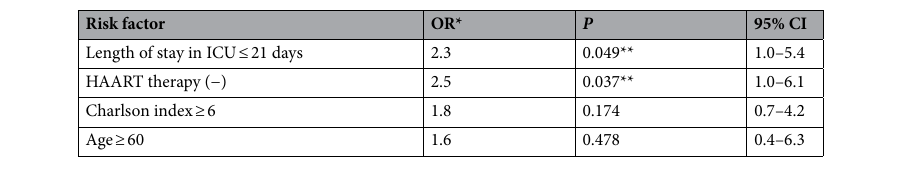
Table 2. Logistic regression analysis of risk factors for mortality in HIV patients in the ICU. *OR adjusted with length of stay in the ICU ≤ 21 days, HAART therapy (−), Charlson index ≥ 6, age ≥ 60. ** p < 0.05.